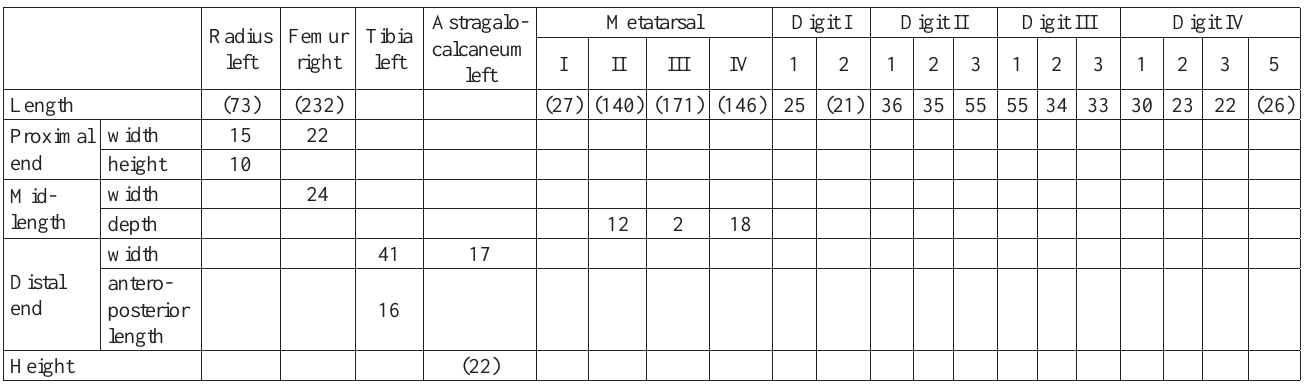
Table 1. Selected measurements (in mm) of Neuquenraptor argentinus (MCF-PVPH-77). Parentheses indicate preserved